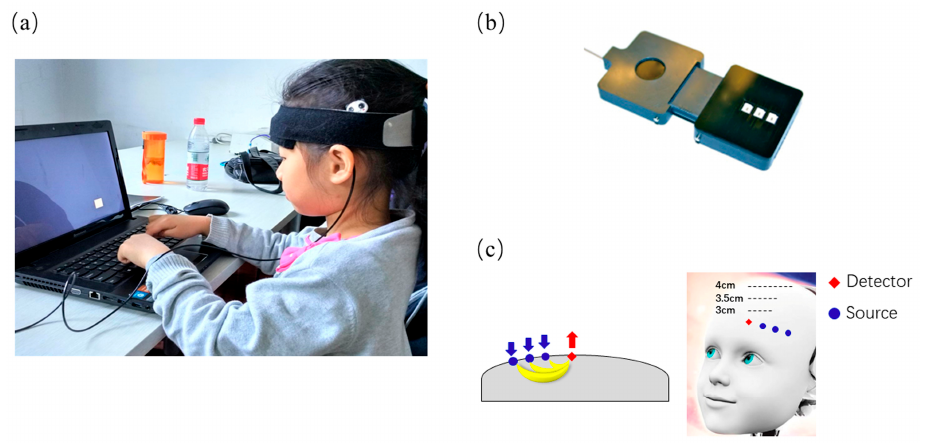
Figure 2. ( a ) Optode placement in our experiment. ( b ) A photograph of the wearable functional near- infrared spectroscope (fNIRS) and ( c ) Schematic diagrams of the channels corresponding to multiple distances of 30, 35, and 40 mm between the sources and the detector.